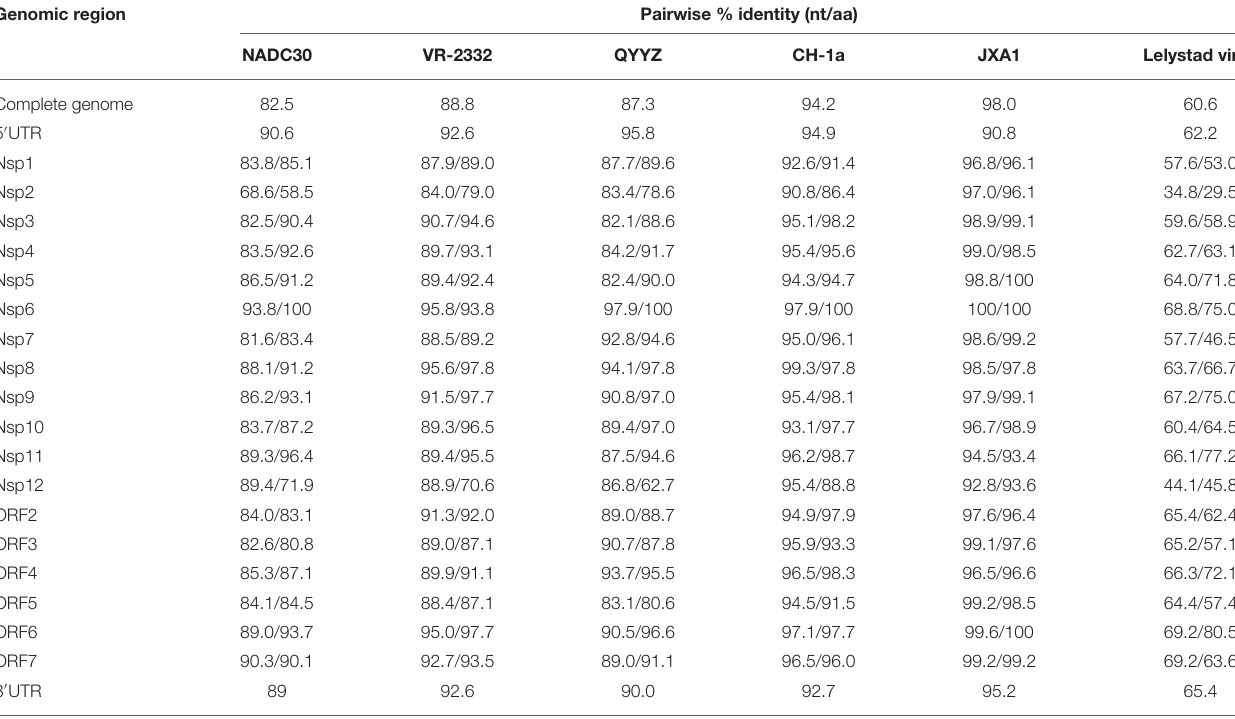
TABLE 2 | Nucleotide and amino acid identities of different regions of GXYL1403 compared with other PRRSV reference strains. Genomic region